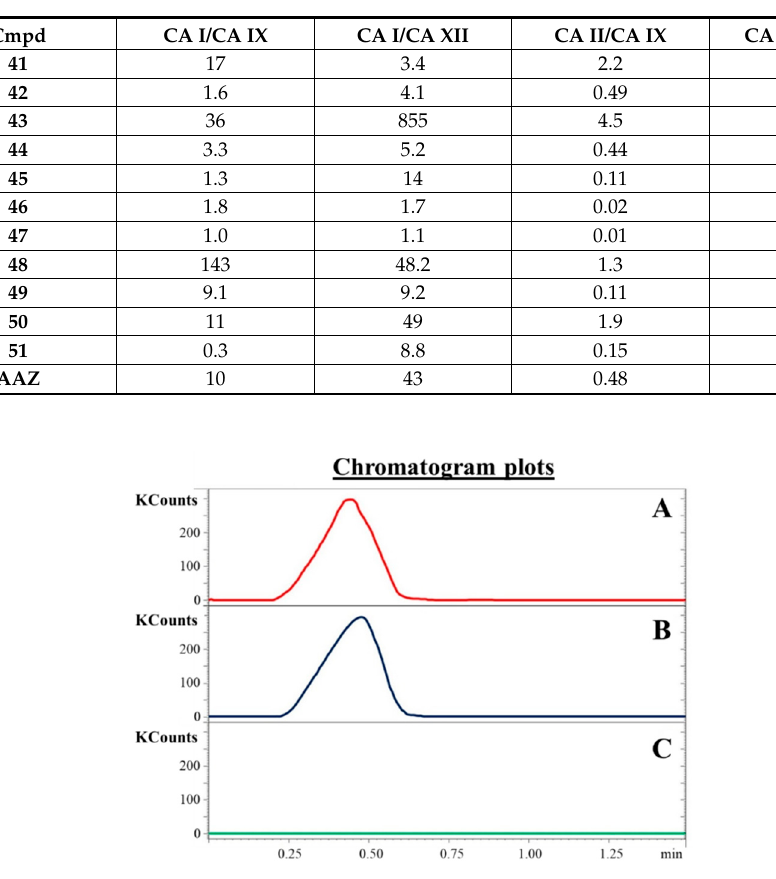
Figure 6. FIA-MS/MS profiles of ( A ) spiked solution (time 0), ( B ) medium solution, and ( C ) cell lysate solution after 2 h of incubation time with Caco-2 cells obtained from analysis of compound 38 . Ligand concentration of 50 μ M in the spiked solution. Limit of detection: 2% of the initial concentration.